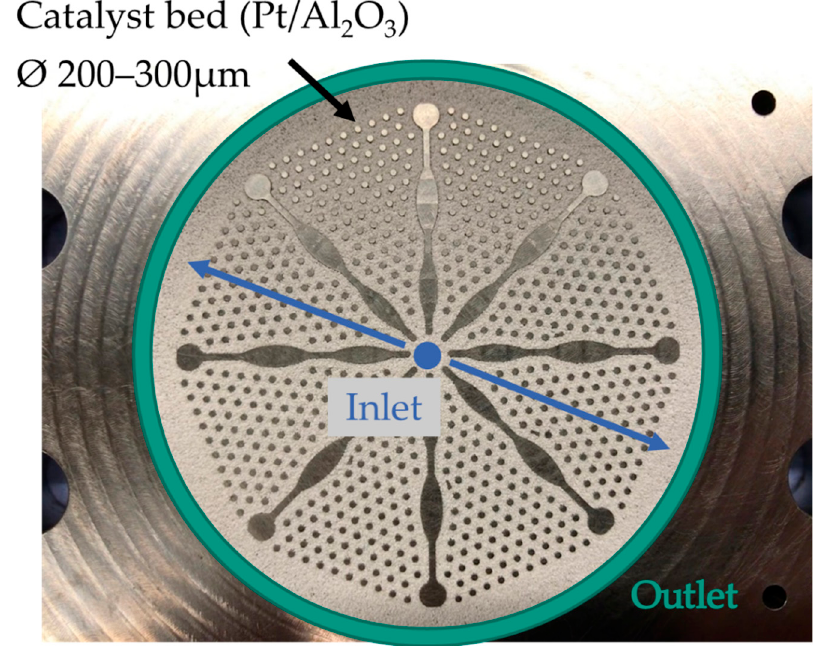
Figure 3. Picture of the microstructure filled with catalyst.